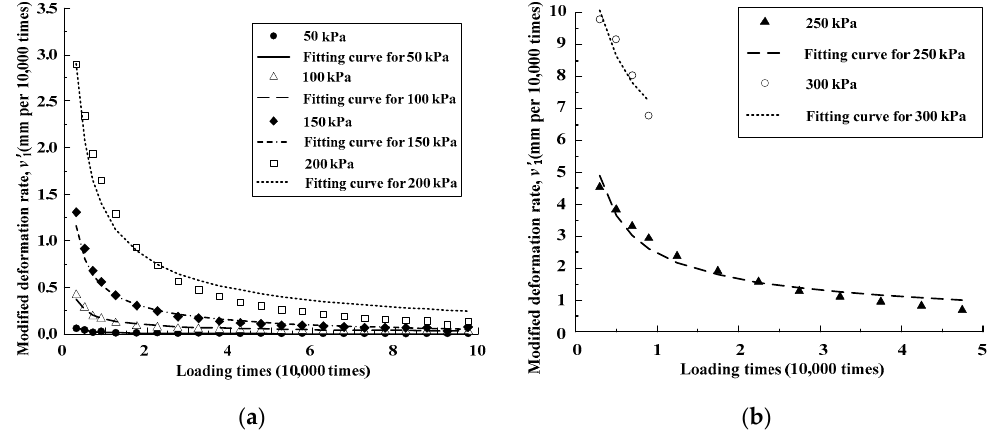
Figure 12. The relationship between modified deformation rate and loading times for Model 1 ( K = 0.9) when cyclic amplitude ranges from ( a ) 50 kPa to 200 kPa; ( b ) 250 kPa to 300 kPa.